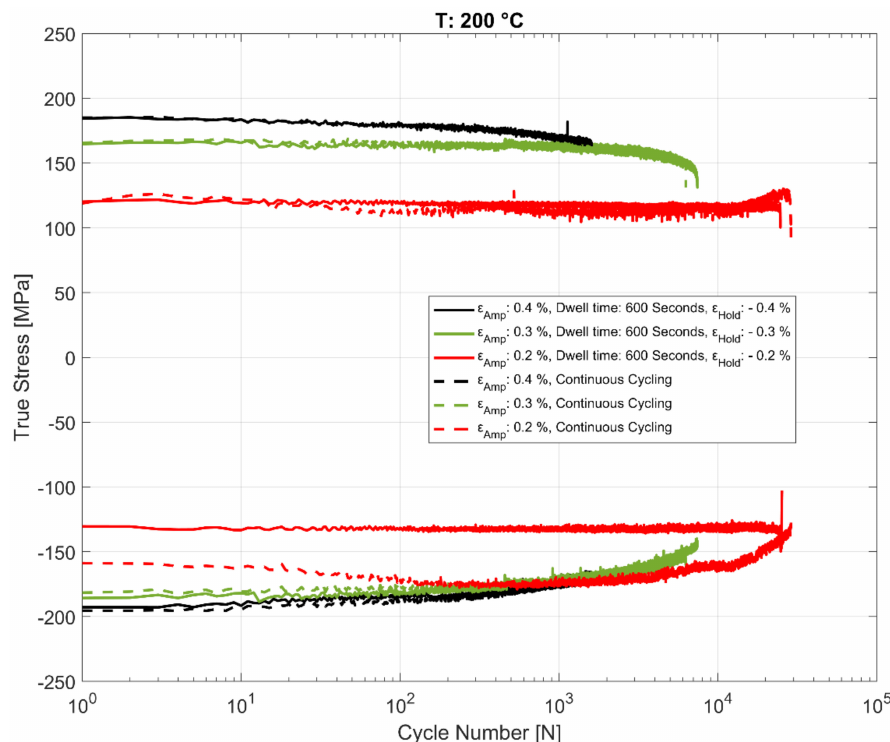
Figure 14. Evolution of peak and trough stress response in strain-controlled fatigue tests with and without hold time at 200 ◦ C.